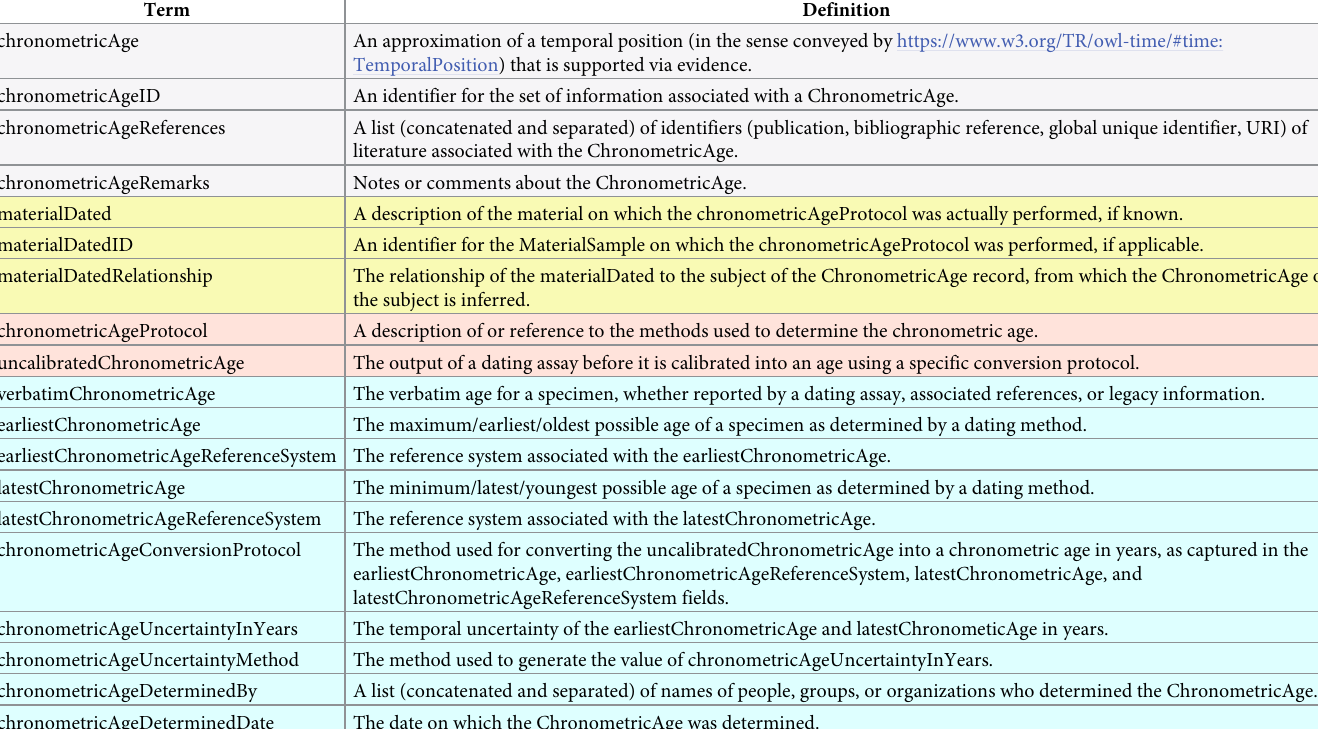
Table 3. The current Chronometric Age extension terms and definitions with notes detailing examples of what is meant by specific field names. This same informa- tion, including notes detailing examples of what is meant by each specific field, can be found at the current published version of the extension on the TDWG website at